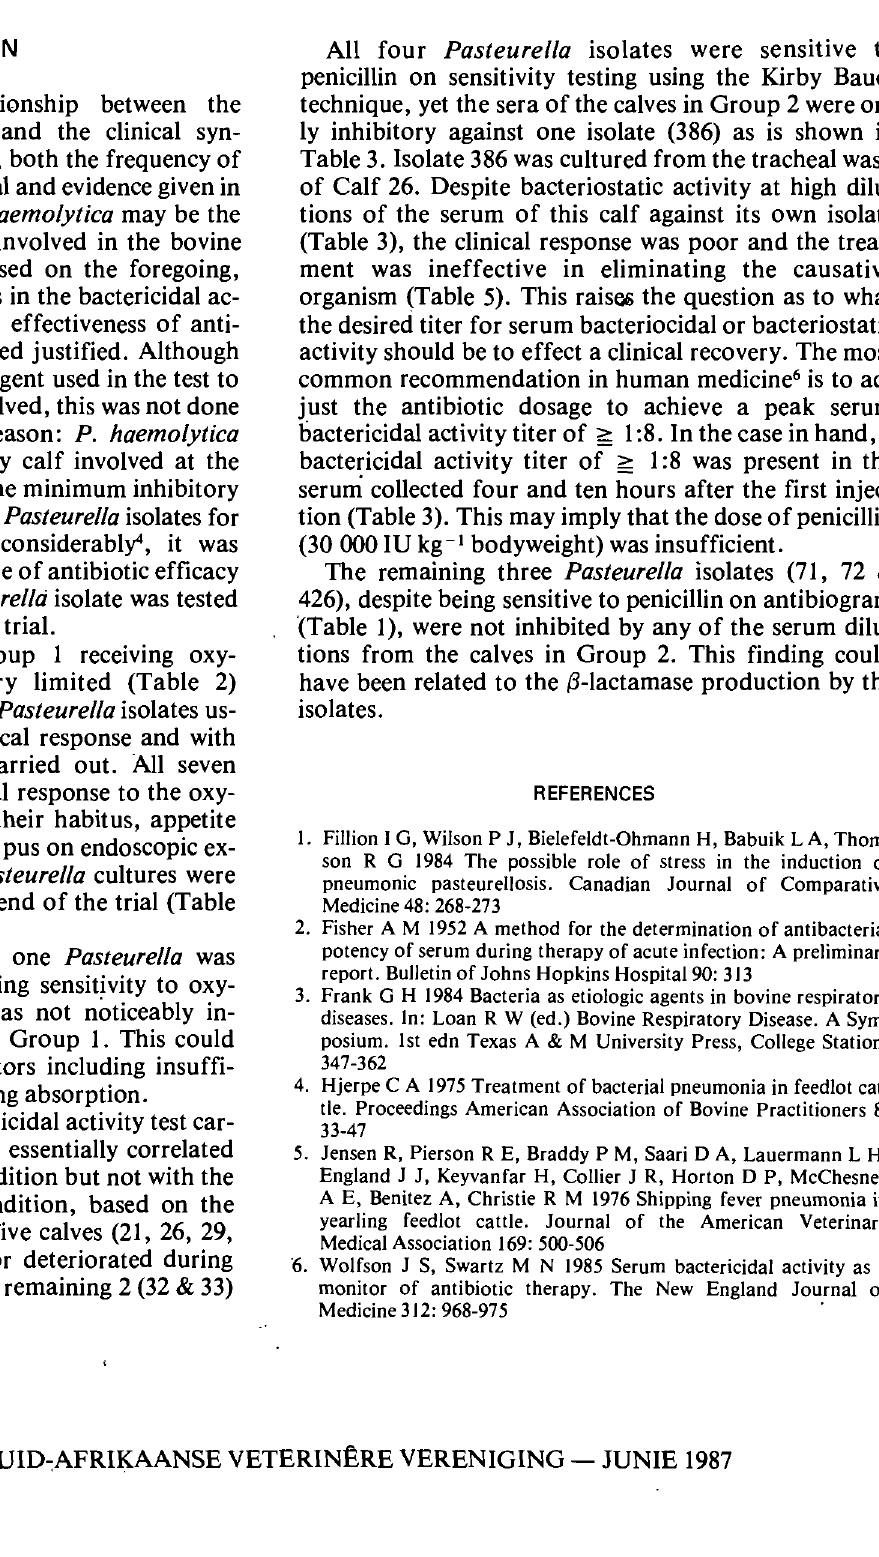
Table 5: The clinical response of the calves in Group 2 receiving penicillin Day of treatment Day 1 Day 4 Animal Temperature Tracheitis Pasteurella Temperature Tracheitis Pasteurella number (OC) + pus . isolation (OC) + pus isolation 21 40;.3 Present Negative 39,4 Present Positive 26 39,0 Present Positive 39,7 Present Positive 29 39,7 Mild Negative 39,8 Mild Negative 31 40,2 Present Negative 39,4 Present Negative 32 39,5 Present Negative 38,4 Absent 33 39,1 Mild Negative 39,7 Absent 34 39,3 Present Negative 41,1